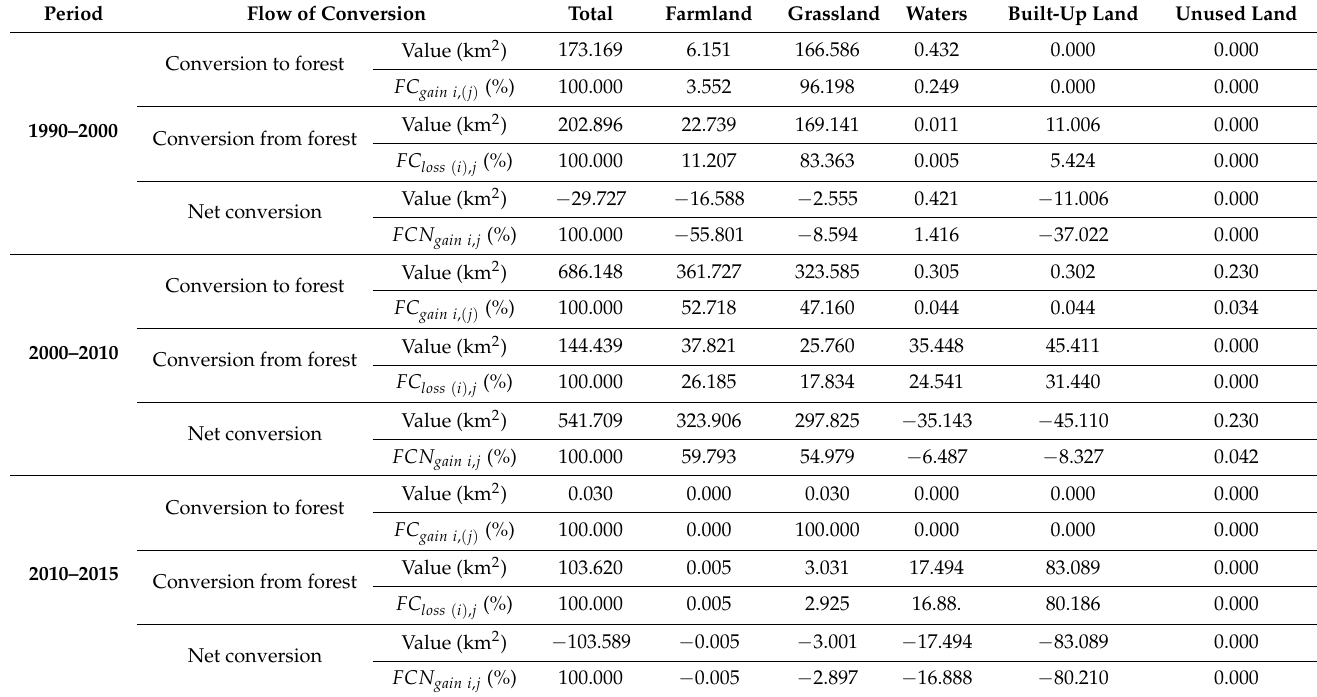
Table 2. Flow rates of forest land use change in Chongqing during 1990–2000, 2000–2010, and 2010–2015 (km 2 ). Period